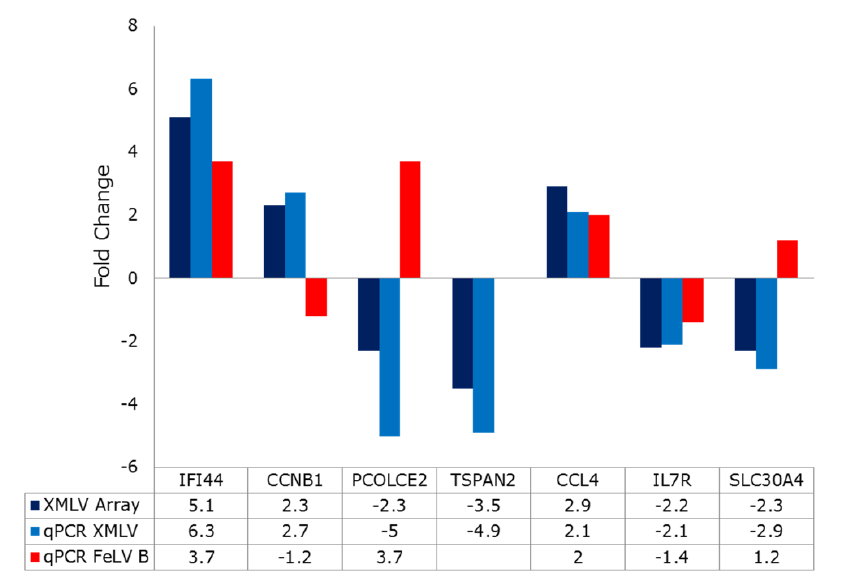
Figure 5. Validation of significant gene expression changes in XMLV-infected Raji cells by quantitative RT-PCR. Fold changes measured by the microarray shown in Figure 4 (dark blue bars) were validated by qtRT-PCR (light blue bars) and the same genes compared in FeLV-B infected Raji cells (red bars). Fold changes are also listed in the table below. Note that all microarray changes were validated, while only a subset of genes are similarly regulated in FeLV-B-infected Raji cells. NA: not